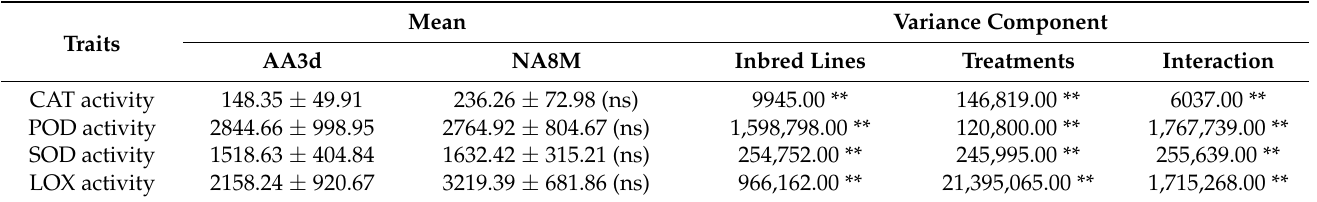
Table 3. Comparison and variance analysis of CAT, POD, SOD, LOX activity and MDA content after AA3d and NA8M